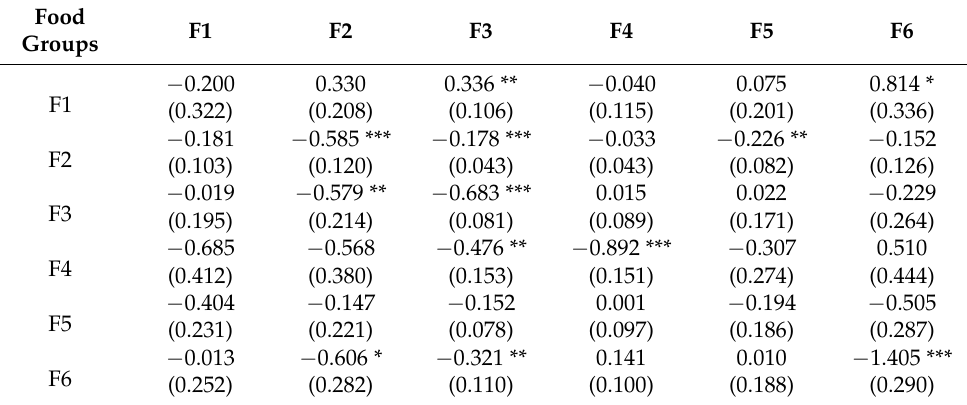
Table A1. Average Uncompensated Elasticities for Various Foods between 2000–2020.